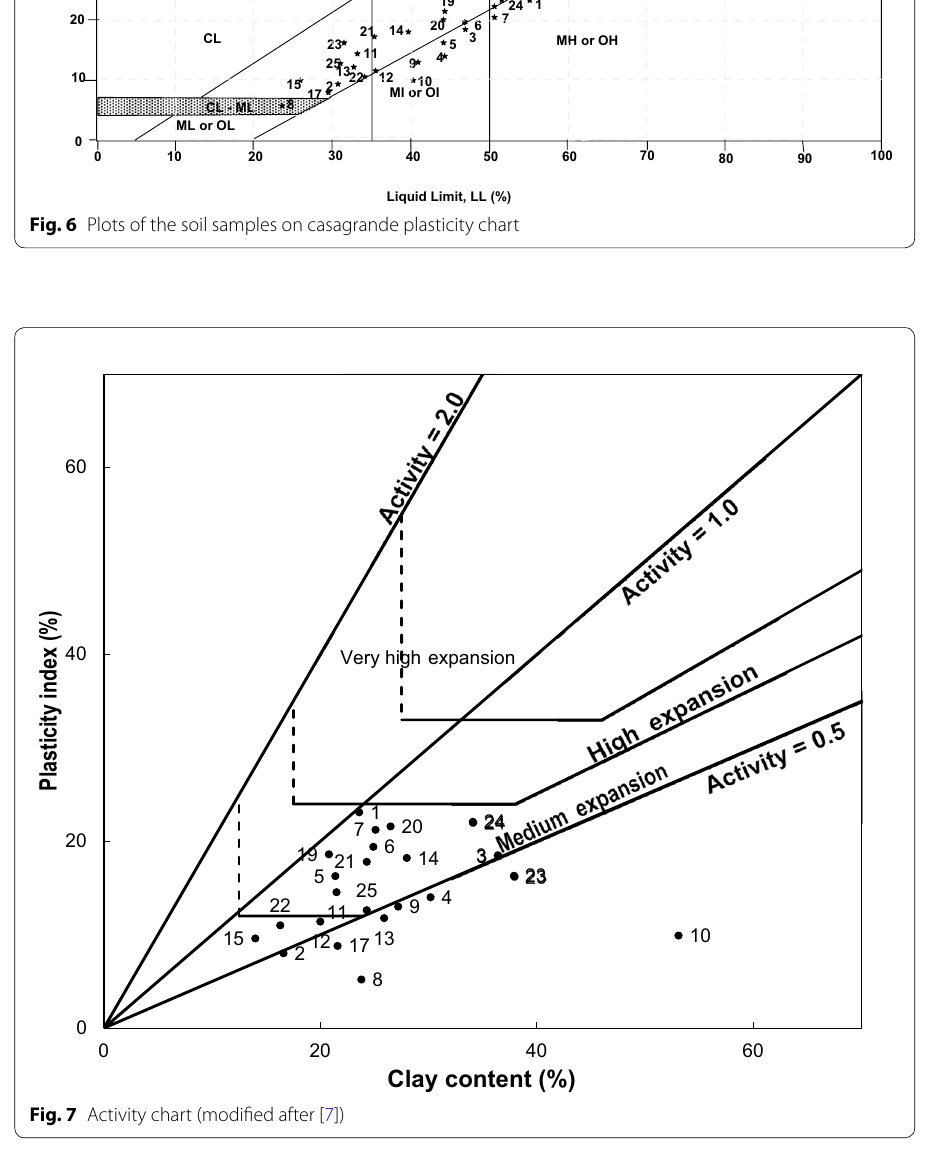
Fig. 7 Activity chart (modified after